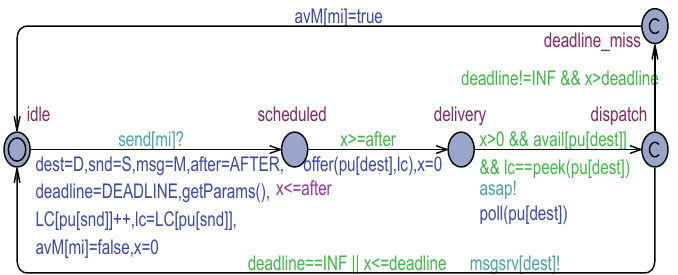
Figure 3. The Message automaton.